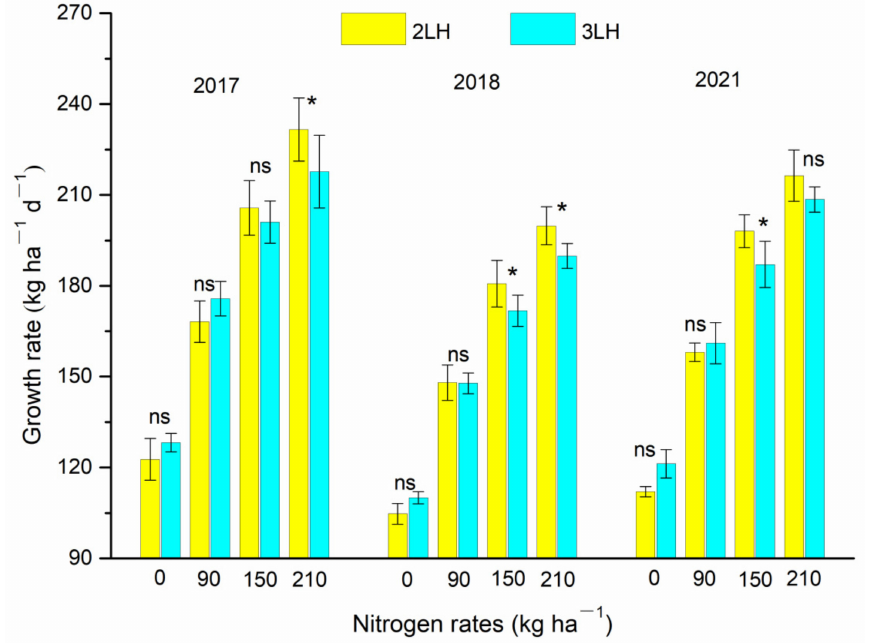
Figure 4. Growth rate of two rice types with different nitrogen rates from jointing stage to heading stage. 2LH: two-line hybrid rice; 3LH: three-line hybrid rice. ns: not significant; *: significant at the p = 0.05